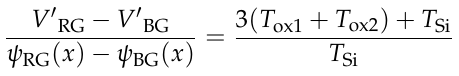
According to (1), ψ RG ( x ) and ψ RG ( x ) represent the surface potential near the right gate and the bottom gate, respectively. V (cid:48) RG and V (cid:48) BG are the difference between the gate voltage and the flat-band voltage, as given by V (cid:48) RG = V RG − V RG_fb and V (cid:48) BG = V BG − V BG_fb . Equation (1) can be rewritten as: